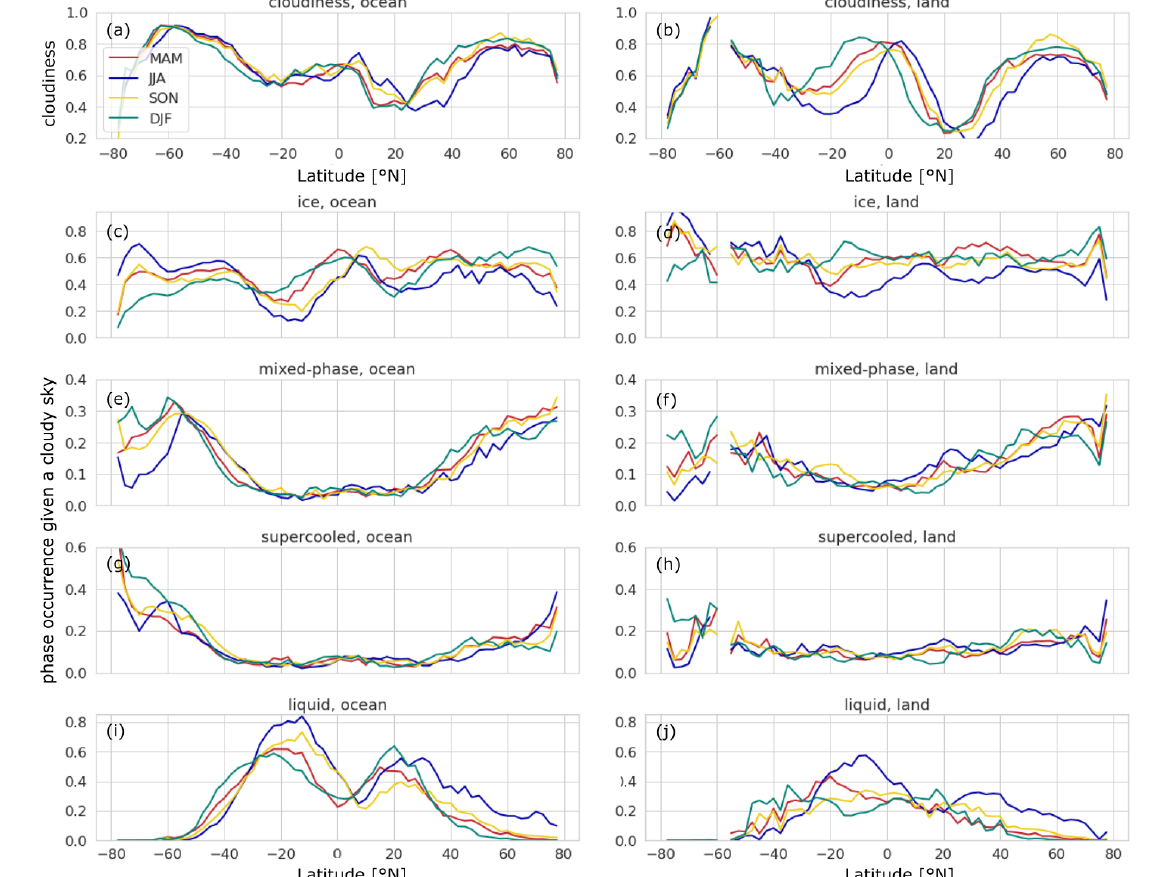
Figure 6. ( a , b ) Probability of cloudy conditions (cloudiness) and ( c – j ) probability of occurrence of CTPs as functions of latitude, season, and surface type (land or ocean). Bins of 2.5 ◦ are used for the